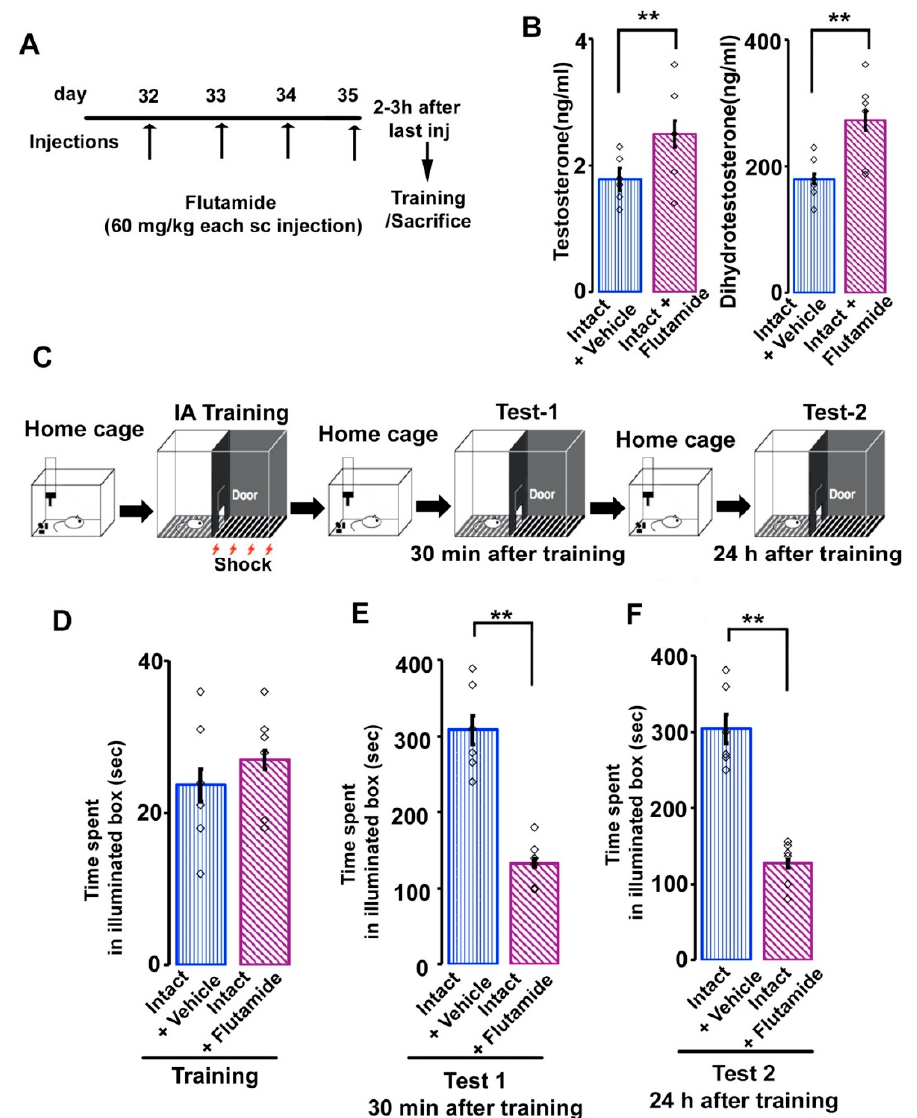
Figure 3. Time spent in illuminated box before entering the dark side of the box in vehicle and flutamide-injected male rats. ( A ) Schematic diagram of the schedule for flutamide injections. ( B ) Serum testosterone (T) and dihydrotestosterone (DHT) concentra-tion. n = 18 for each group. ( C ) Diagram of experimental design of inhibitory avoidance task. Rats were housed in a home cage but moved into the light box used for the task on the training day. A brief electrical foot-shock (2 s) was applied in the dark box in the shock cage. ( D ) time spent in illuminated box before training, ( E ) 30 minutes after training or ( F ) 24 h after training of vehicle and flutamide-treated intact rats. Values are the mean ± SEM. ** p < 0.001. n = 6 for each group. White rectangles in ( B ), ( D – F ) represent data